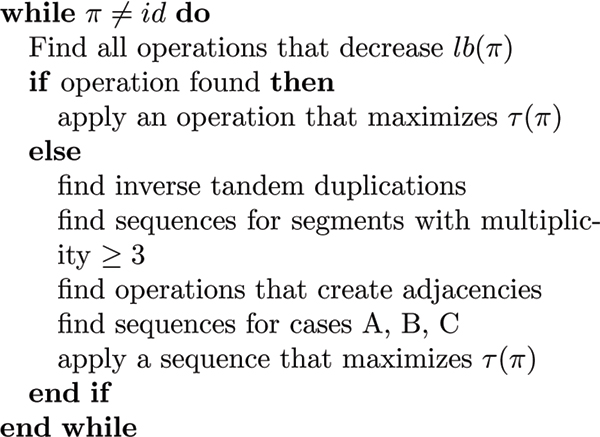
The algorithm. The algorithm in pseudocode.